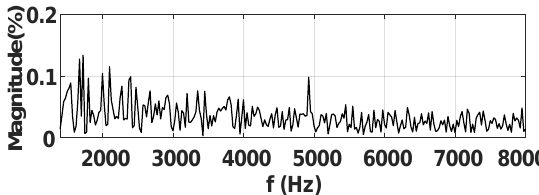
Figure 10. The spectrum of the conventional CF